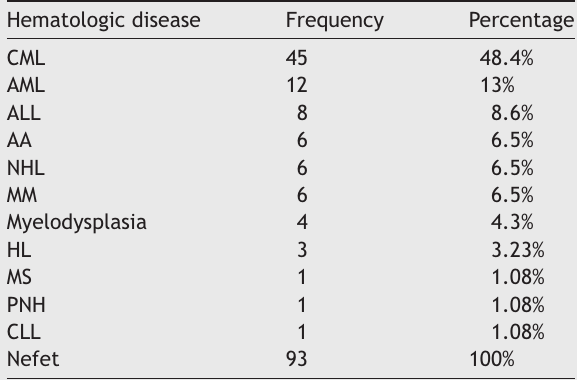
Rhinosinusitis (RS) vs . type of autologous and allo- genic hematopoietic stem cell transplantation